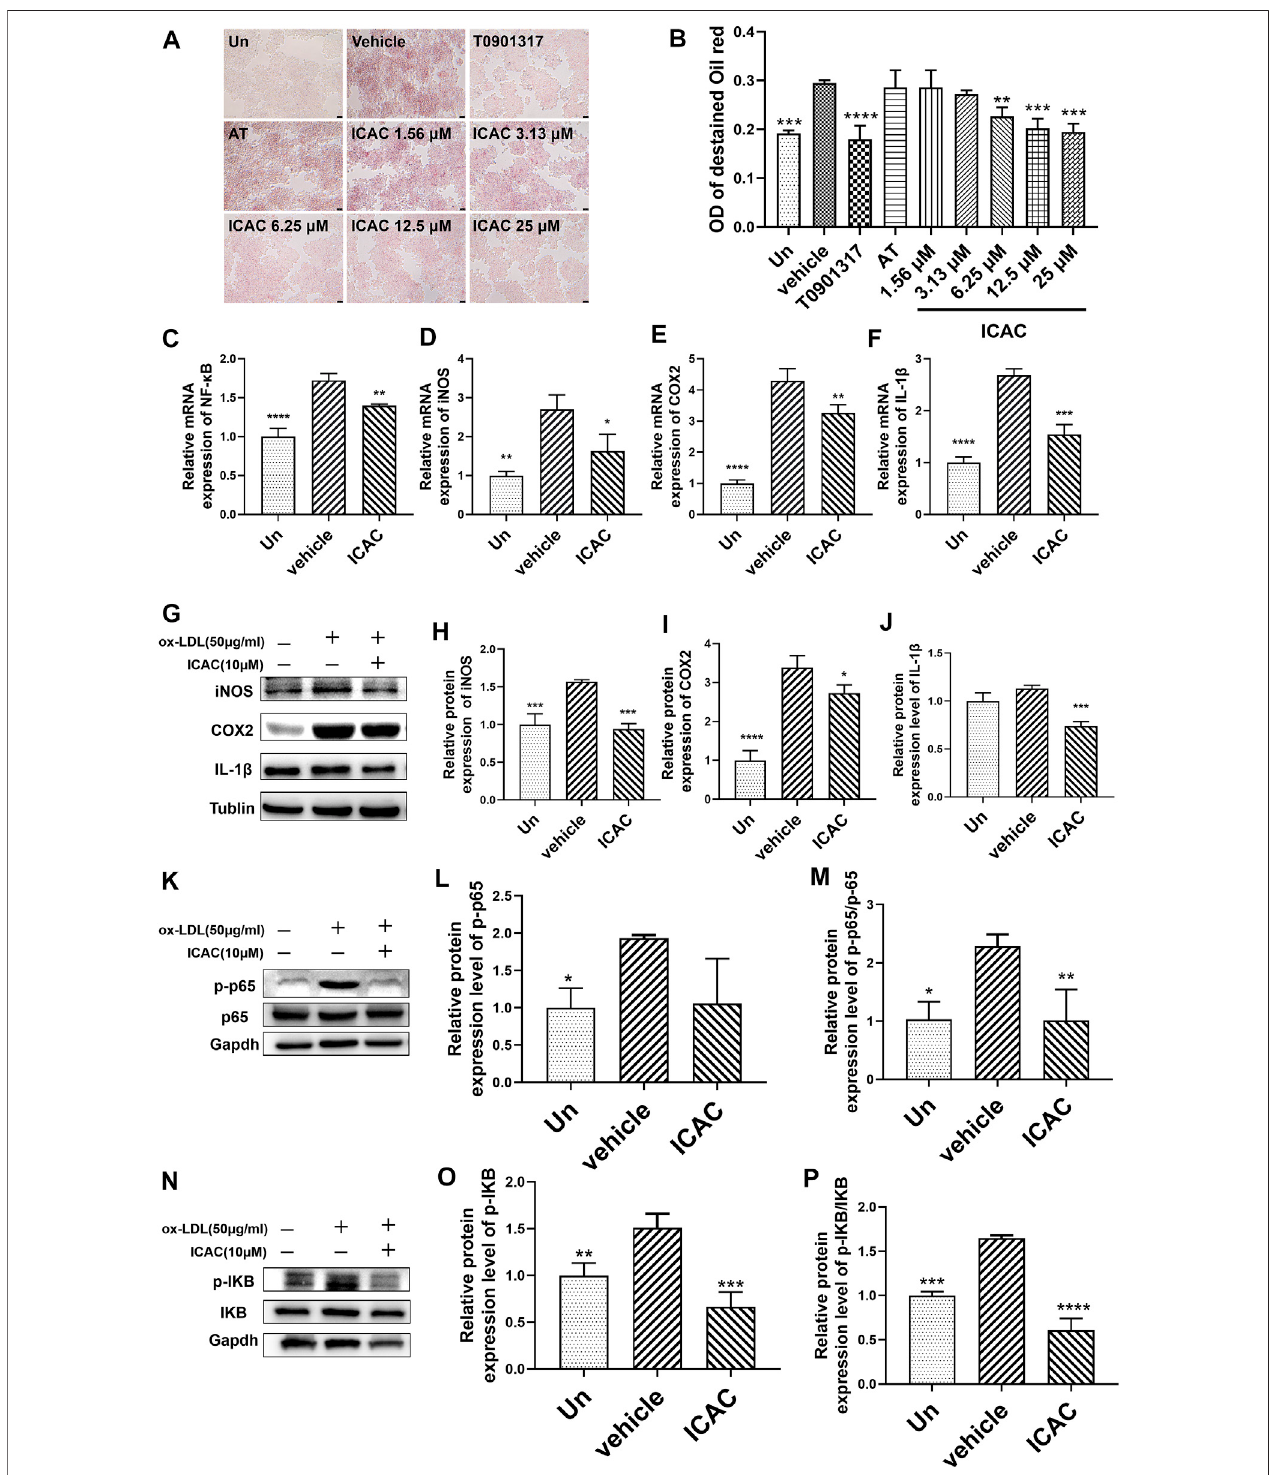
FIGURE2| ICACinhibitsox-LDL-inducedfoammacrophageformationandin fl ammatoryresponse. (A) OilredOstainingoflipidaccumulationinBMMsstimulated by ox-LDL. (B) Quanti fi cation of ORO staining in BMMs ( n = 3). (C – F) Gene expression level of NF- κ B, iNOS, COX, and IL-1 β in BMMs. (G – J) Protein expression level of iNOS, COX2, and IL-1 β in BMMs. (K – M) Protein expression level of NF- κ B pathway. All data in (B – F, H – J, N, M, O, P) were represented as mean ± SEM. Statistical difference was determined by one -way ANOVA test. Compare with a vehicle, * p < 0.05, ** p < 0.01, *** p < 0.001, **** p < 0.0001. n = 3 for each group.